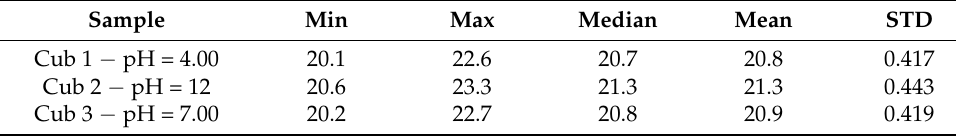
Table 2. Summary of the temperature data from the investigated pH values.